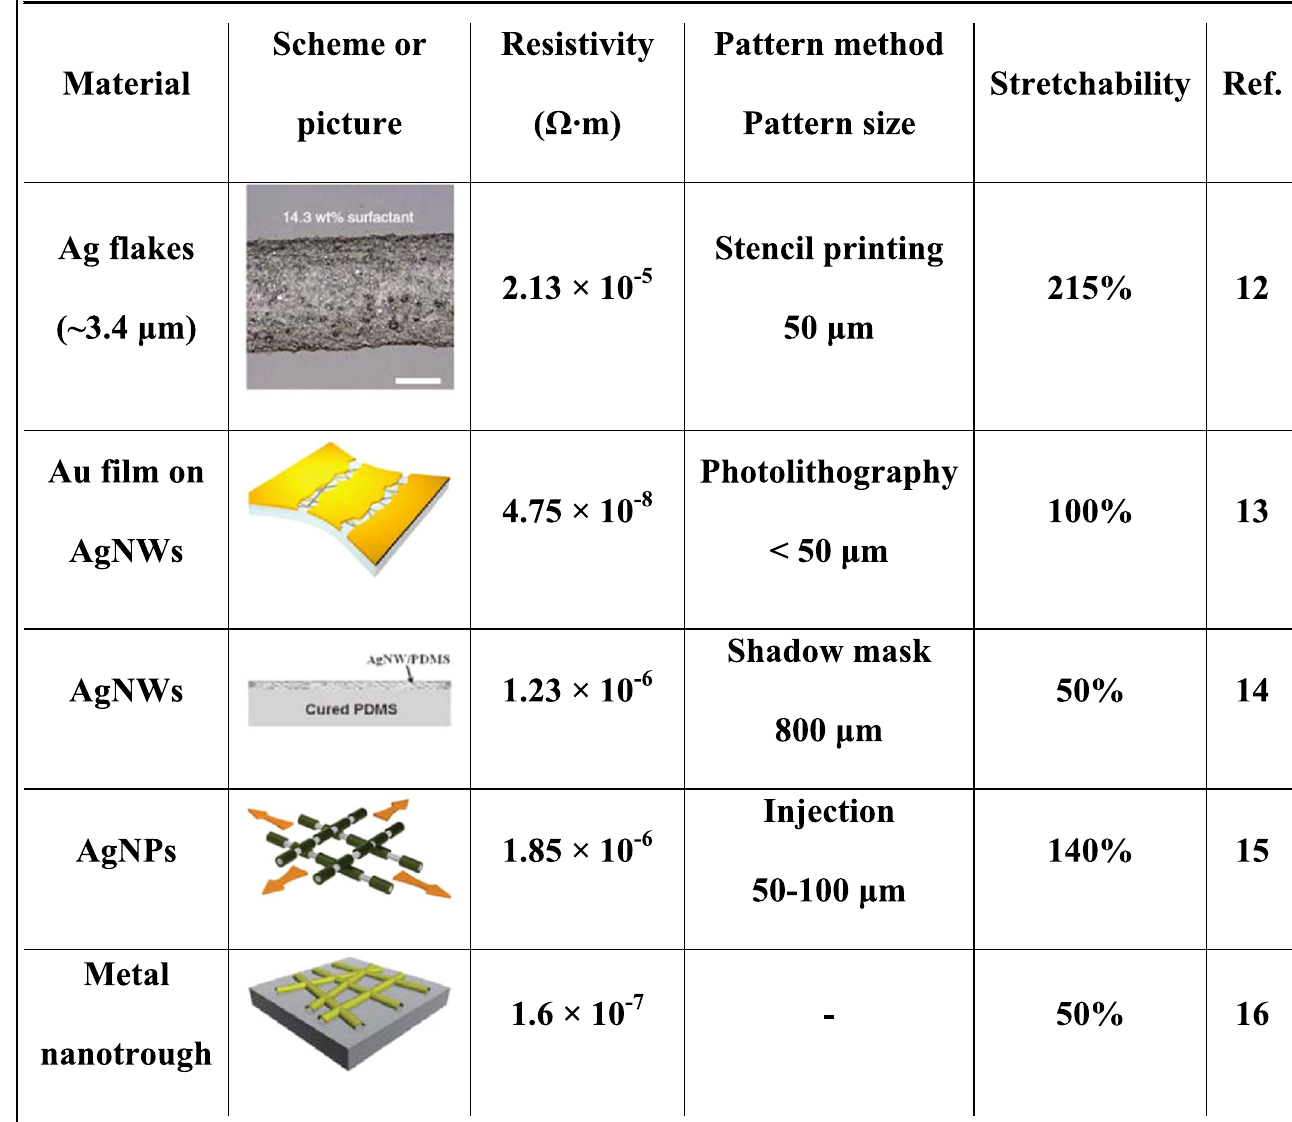
Table 1. Summary of the performances of stretchable conductors for